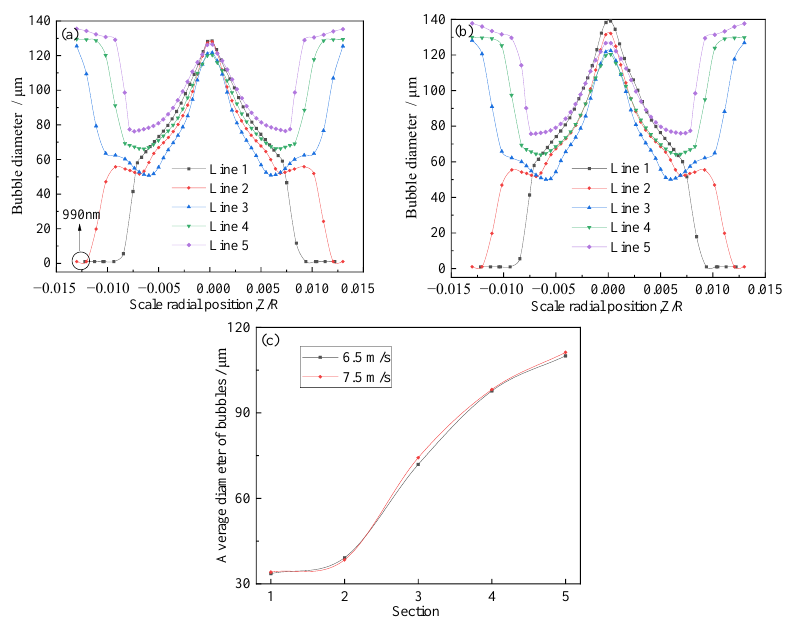
Figure 7. Distribution of bubble diameters at different sections at an ( a ) inlet flow velocity 6.5 m/s, ( b ) inlet flow velocity 7.5 m/s, ( c ) inlet flow velocity 6.5 m/s, and 7.5 m/s average diameter of bubbles at different sections.